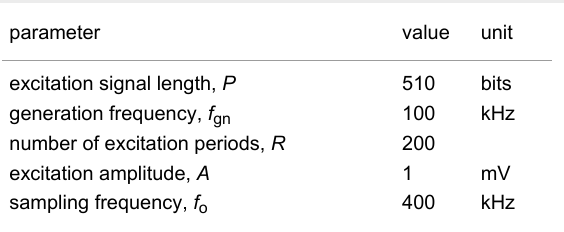
provide enough energy to the whole frequency band. Because the measured signal levels were extremely low, a large number of excitation periods and averaging were used to reduce the effect of noise. Two hundred periods were used in the experiment. The total length of the excitation signal was L = 200·2·(2 8 − 1) = 102,000. With these parameters, the lowest frequency harmonic was 100 kHz/510 ≈ 196 Hz. The sampling frequency f o was set to four times the generation frequency (400 kHz) to provide reasonable multi-sampling [17]. Table 1 summarizes the parameters used in the experiment. Table 1: Parameters used in the